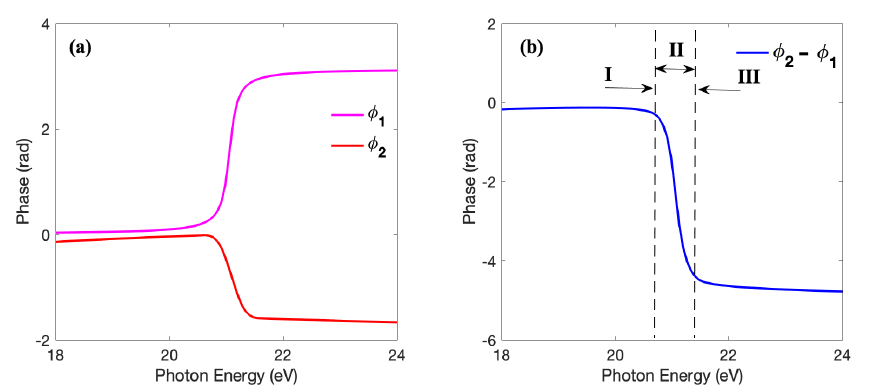
Figure 3. ( a ) Phase of φ 1 and φ 2 and ( b ) their difference φ 2 − φ 1